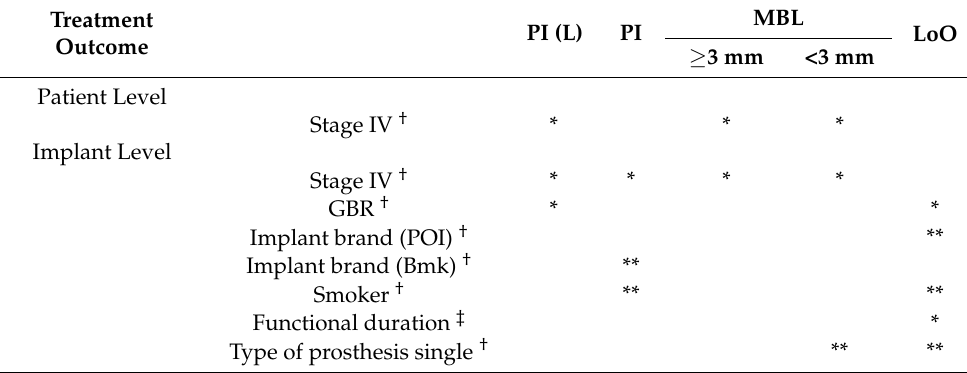
Table 3. Factors related to implant failure (peri-implant disease, lack of osseointegration). Treatment